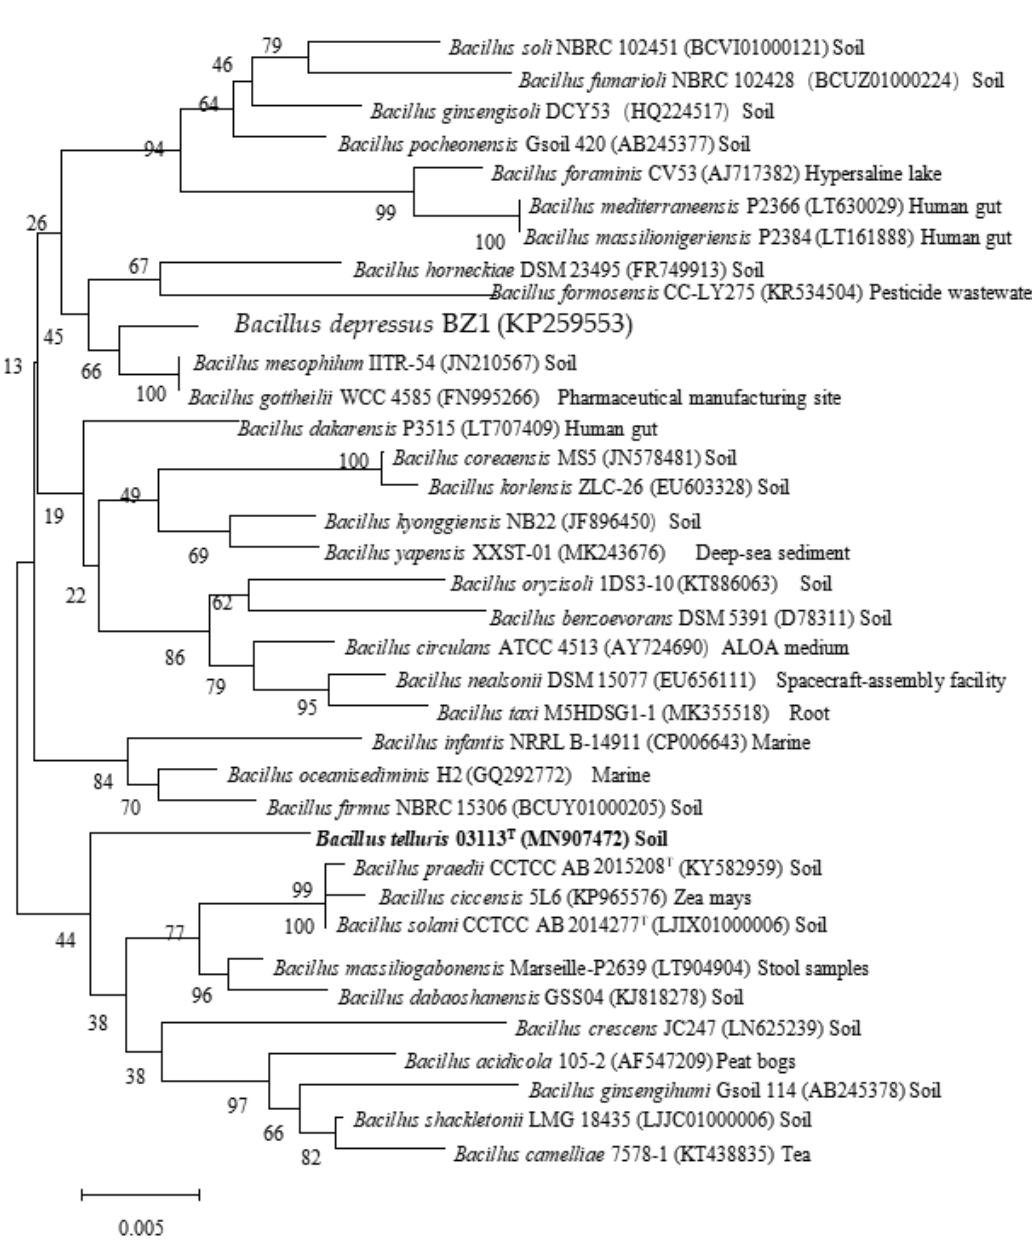
Figure 1. Neighbour-joining phylogenetic tree based on the 16S rRNA gene sequence of strain 03113 T and other closely related Bacillus species. The significance of each branch is indicated by a bootstrap value (%) calculated for 1000 subsets. Genbank accession numbers are given in parentheses. Bar, 0.005 substitutions per nucleotide position. Isolating source label has been annotated in the back.